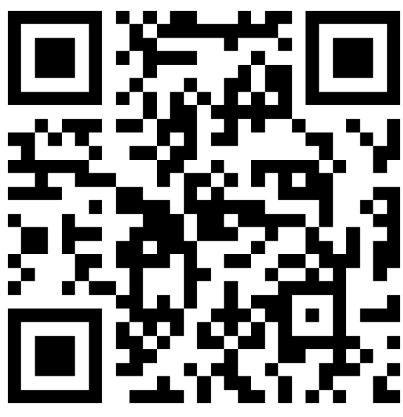
Figure 20. QR code – view model in AR (iOS